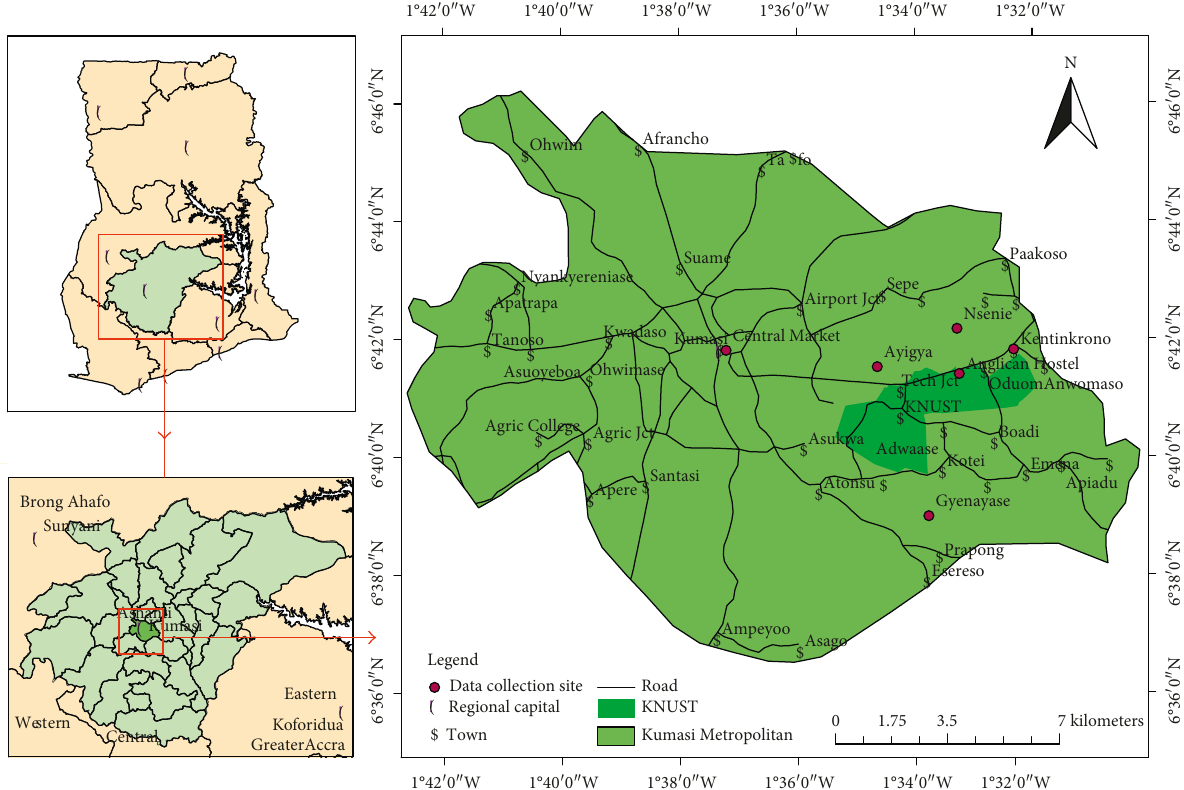
Figure 1: A map showing the study areas in Kumasi, Ashanti Region,